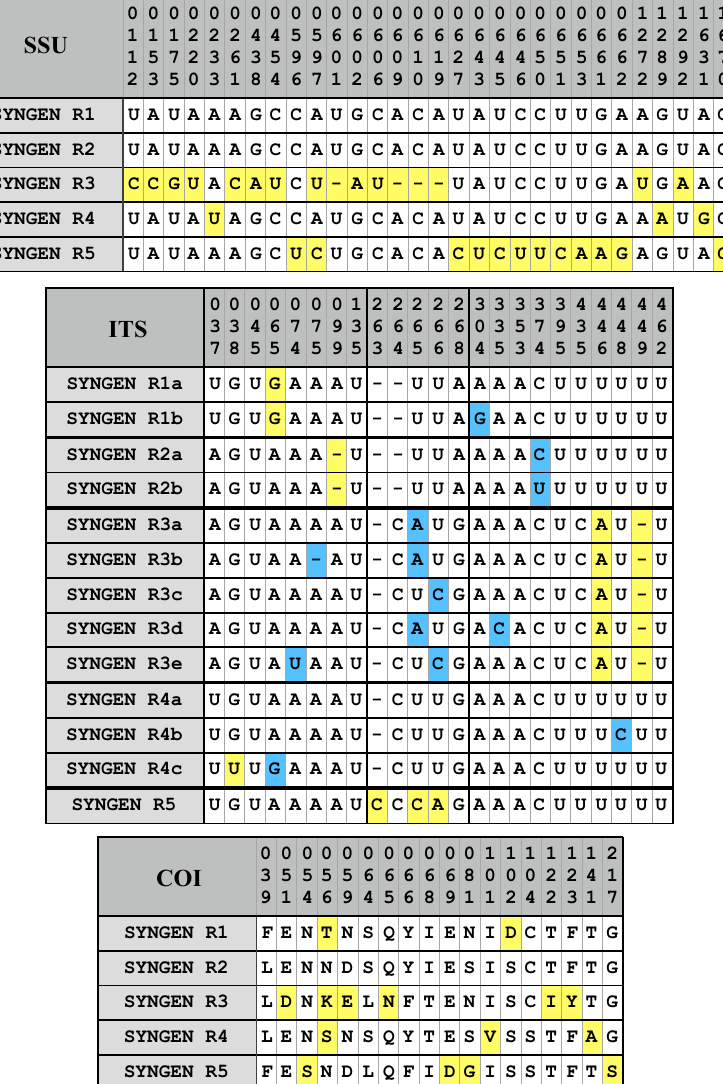
Figure 3. Variable base positions among the SSU, ITS rRNA, and COI sequences of the five syngens among the Paramecium bursaria species complex. The unique synapomorphies are highlighted in yellow, variable positions marked in